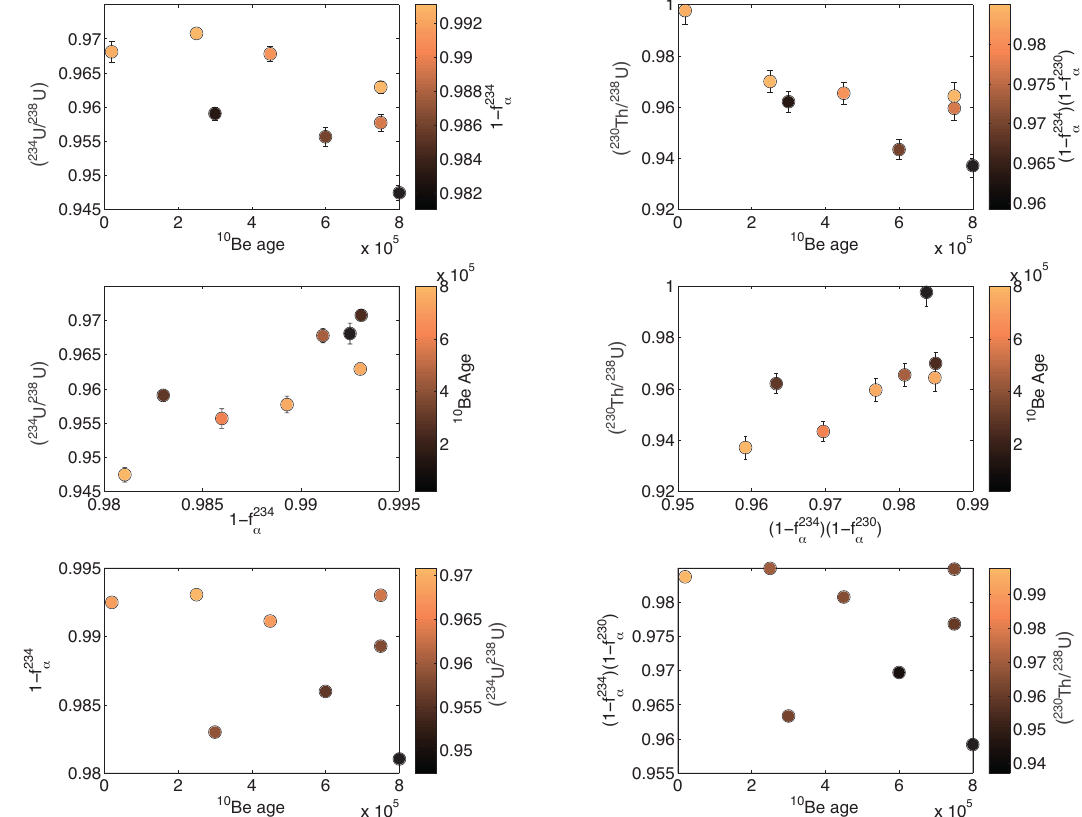
Figure 5. 2-D cross plots of 234 U / 238 U and 230 Th / 238 U activity ratios, associated recoil loss factors (1 − f 234 α ) and (1 − f 234 α ) × (1 − f 230 α ), and 10 Be exposure ages. Symbol colors represent the third parameter in each plot. The sorting observed in the symbol colors helps to explain the noise associated with the other two parameters. In particular, the scatter in the decrease of the activity ratios over time can be largely explained by the variability in the recoil loss factor (top left plot). The plots also let us assume that the variability in the weathering coefficients could be low; otherwise a residual dispersion would be observed. In all cases, error bars are smaller than the size of the